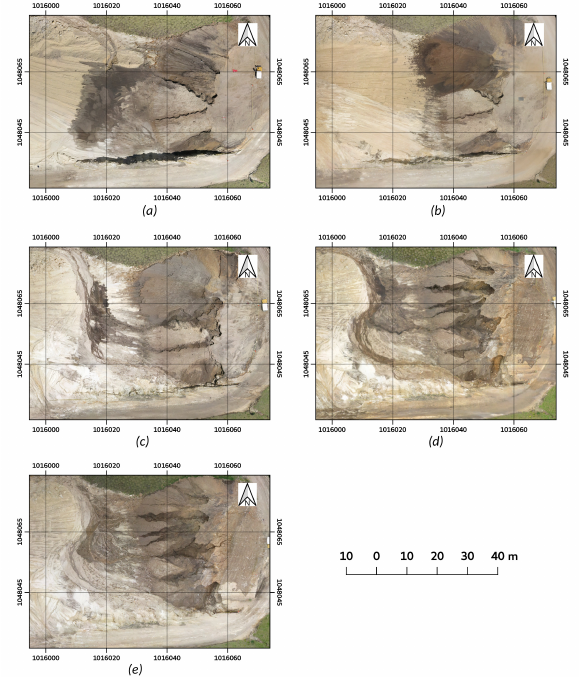
Figure 8. Orthomosaics obtained for all months under study: (a) January; (b) February; (c) March; (d) April; and (e) May. trast, between the periods of April and May, the changes in the terrain were minimal, this corresponded to a decrease in rainfall intensity mainly in the month of May.